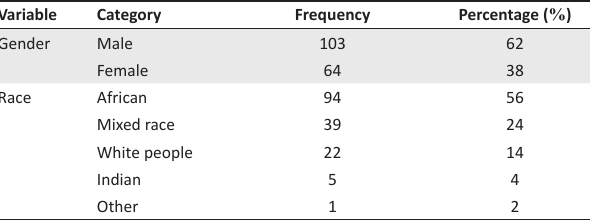
TABLE 1: Characteristics of respondents ( n = 167).